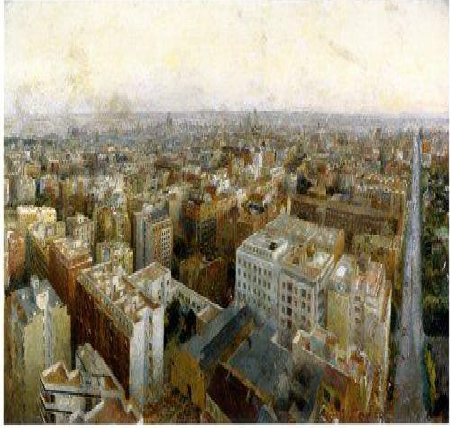
Fig. 20 View of Madrid from Martínez Campos 1960, oil painting on board, 48 x 96 oil